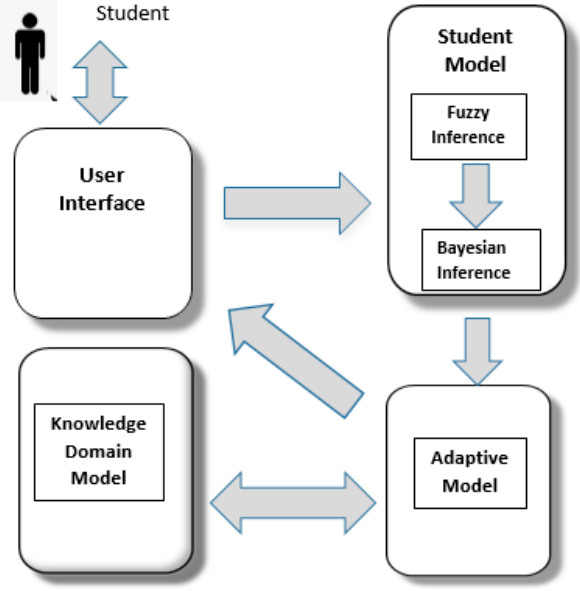
Figure 1. Basic architecture of fuzzy Bayesian intelligent tutoring system (FB ‐ ITS).